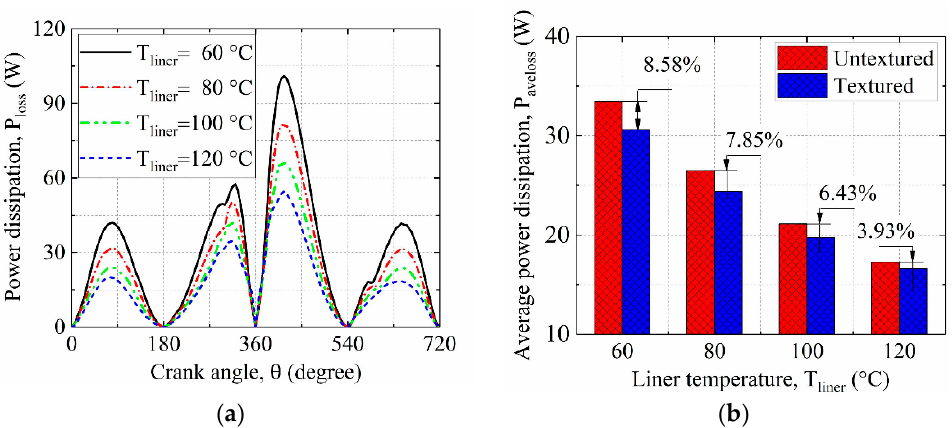
Figure 17. Power dissipation and average power dissipation of the textured RLC for different liner temperatures: ( a ) Power dissipation; ( b ) average power dissipation.